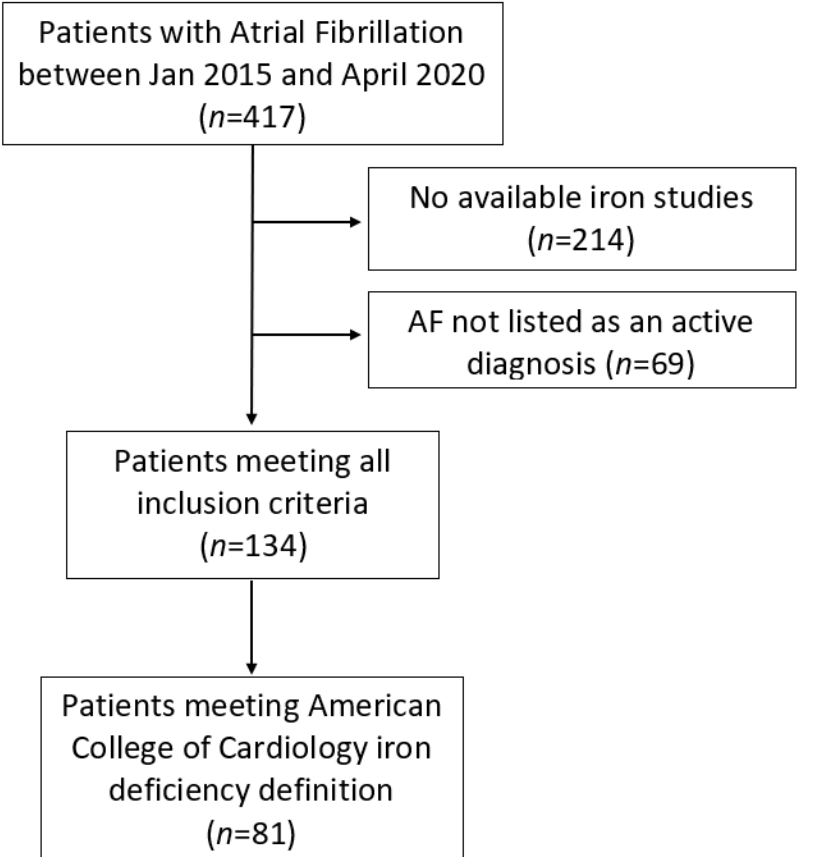
Figure 1. Flow diagram of patient inclusion. Table 1. Baseline Clinical, Echocardiographic and Serological Characteristics.